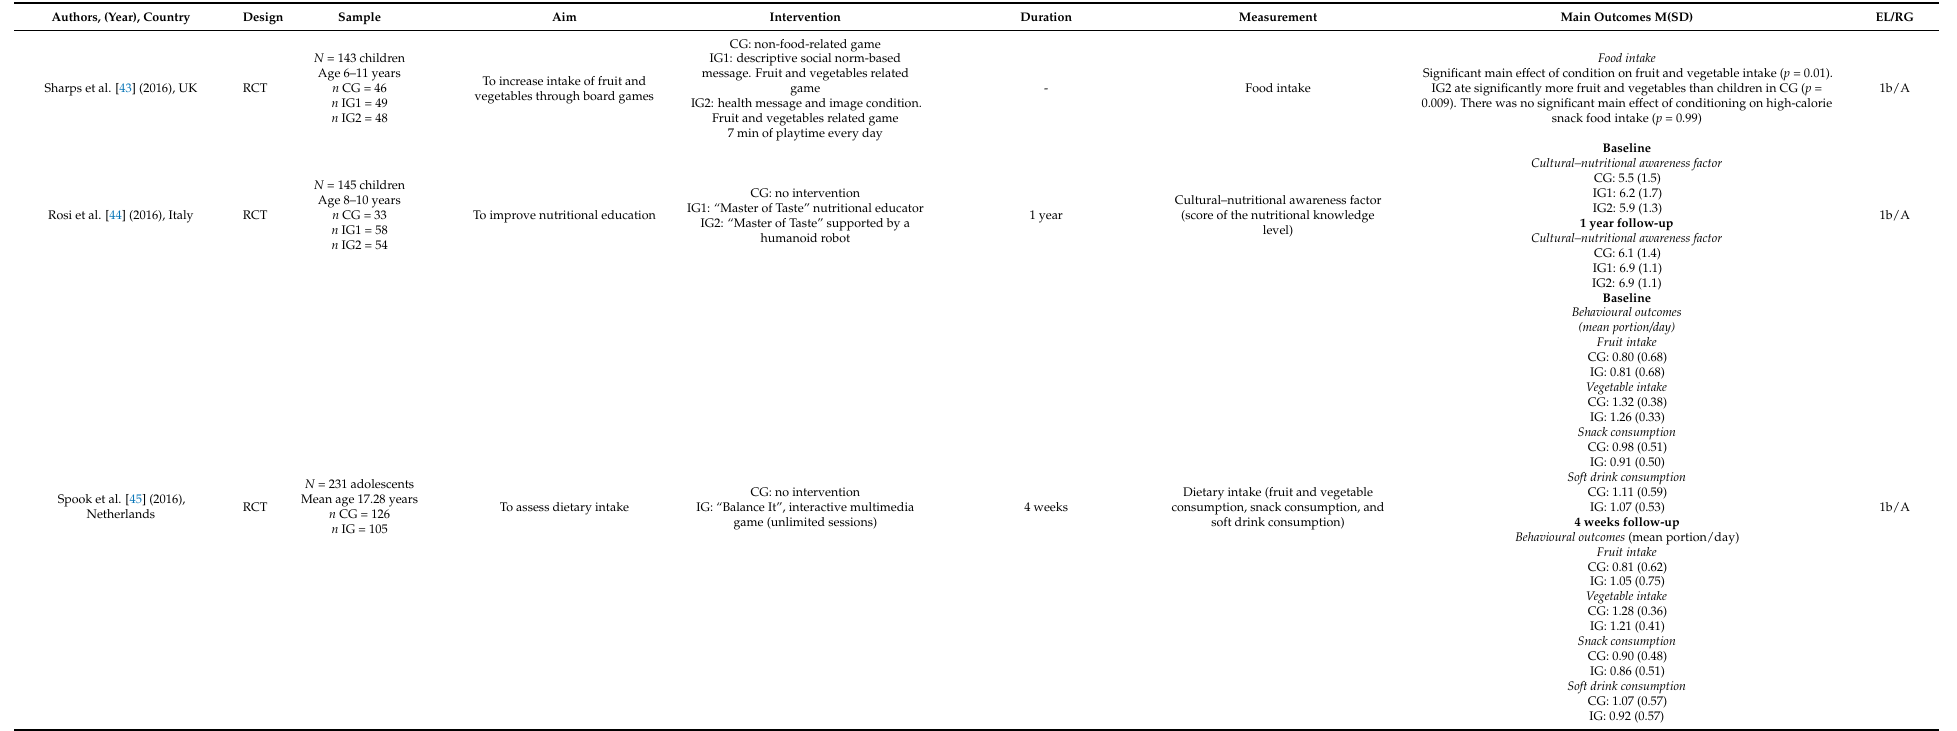
CG:non-food-relatedgame IG1: descriptivesocialnorm-based message.